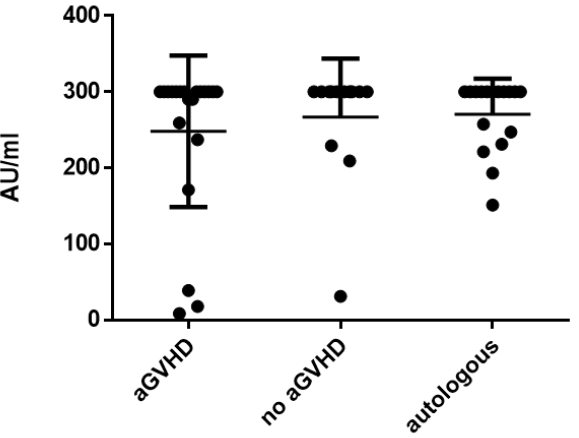
Figure 2. Mean measles titers comparing patients with acute GvHD vs. non-GvHD vs. autologous patients.